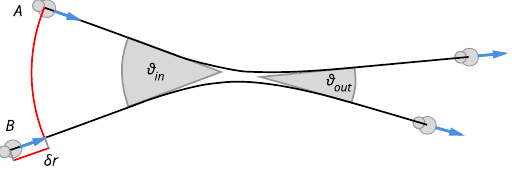
Figure 5. Binary collision. Schematic view of a collision of two cells, labelled A and B, with an incoming angle ϑ ϑ in and outgoing angle out . The difference in the distances of the cells to the collision centre before the collision is given by δ r